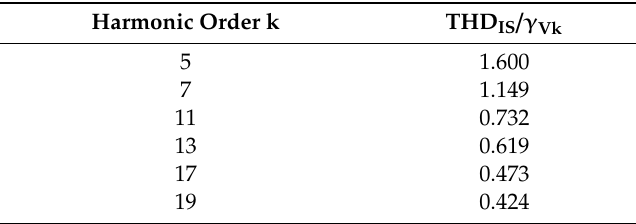
Table 4. The values of the ratio THD IS / γ Vk related to the harmonic voltage